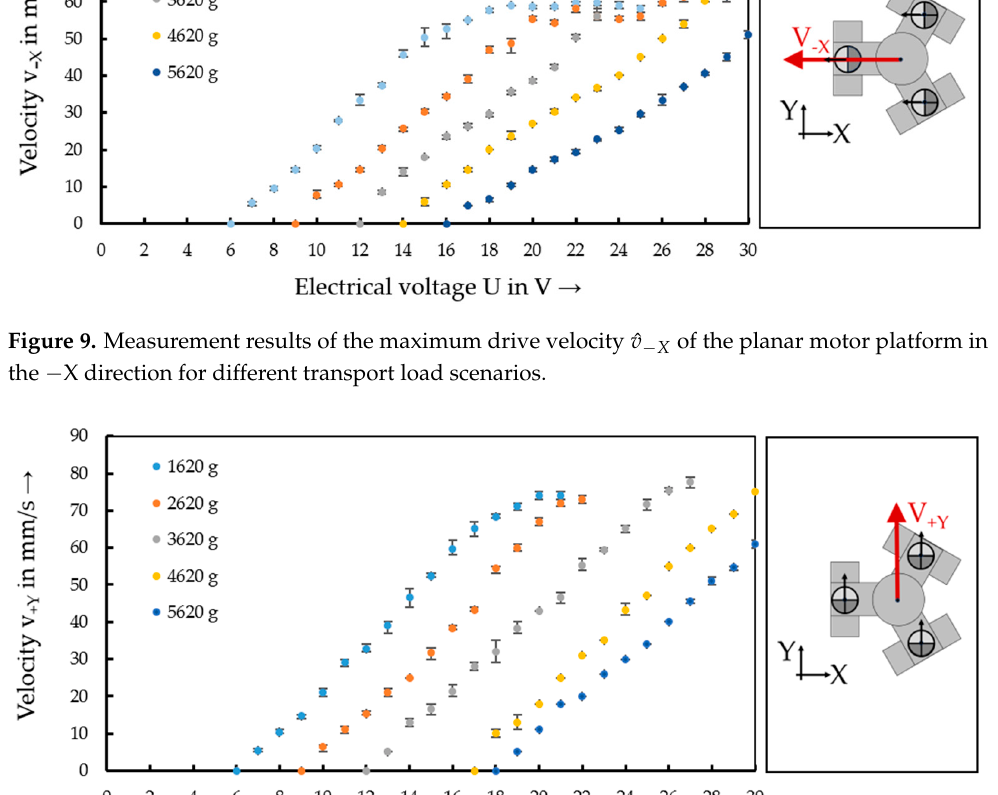
Figure 10. Measurement results of the drive velocity ˆ v + Y of the planar motor platform in the +Y direction for different transport load scenarios. Table 3. Appropriate operating ranges for velocity in the +Y